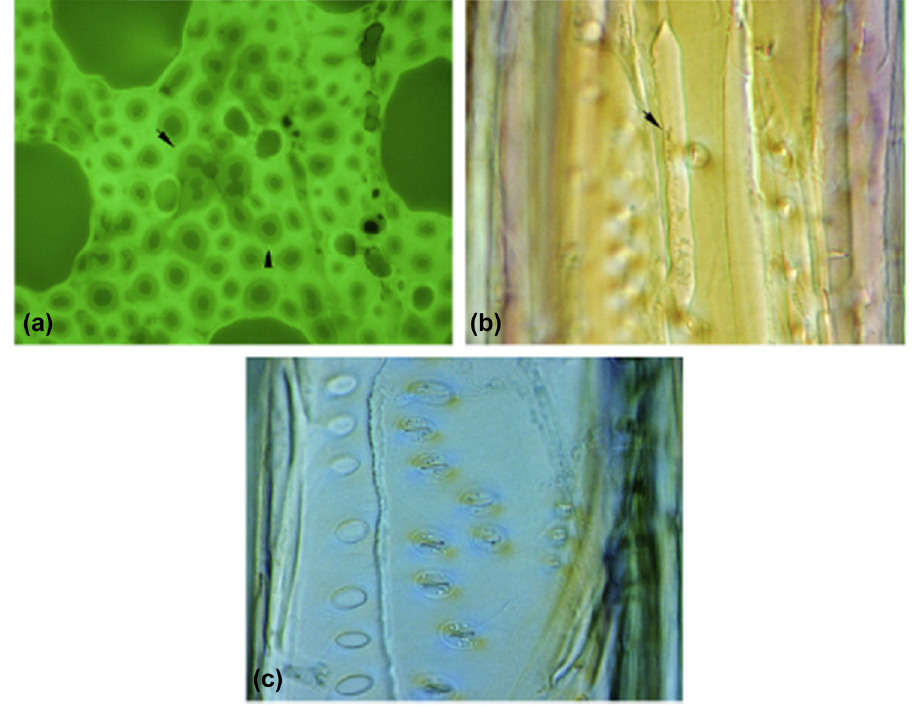
Figure 4: Microbial degradation in acetylated beech wood: WPG 9.6%. ( a ) Darker area indicates white rot decay developing ( arrow heads ) ; cross section, fl uorescent light. ( b ) Soft rot decay ( arrow heads ) ; radial section, Nomarsky. ( c ) Bacteria in vessel pits; radial section, Nomarsky [ 43 ]